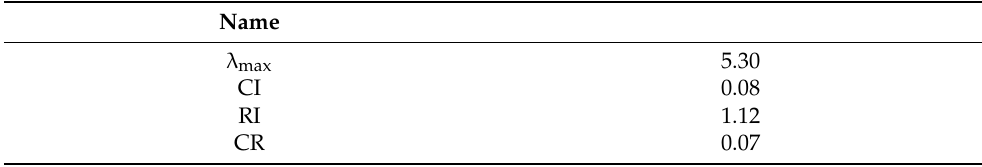
Table 8. The verification coefficients of the correctness of pairwise comparison of main criteria.